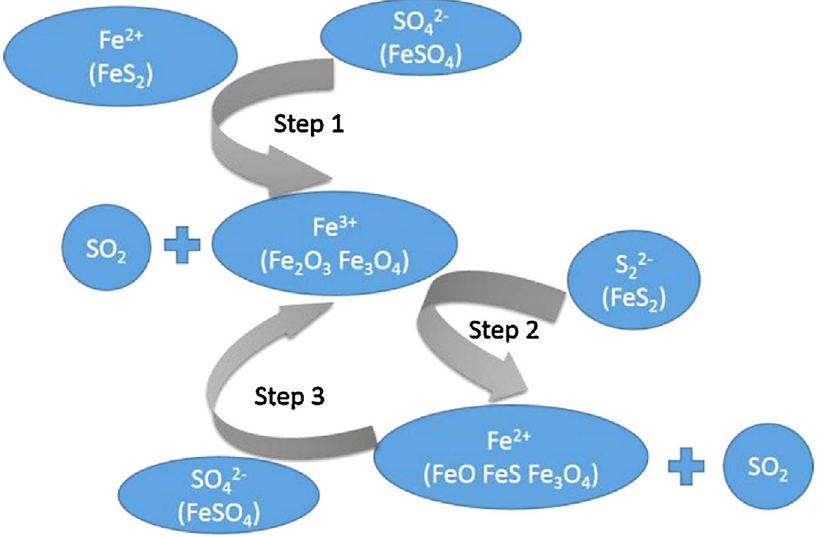
Figure 4. Reaction mechanism of autocatalytic ferrous sulfate decomposition [65] (with permission from Elsevier, copyright year 2022).